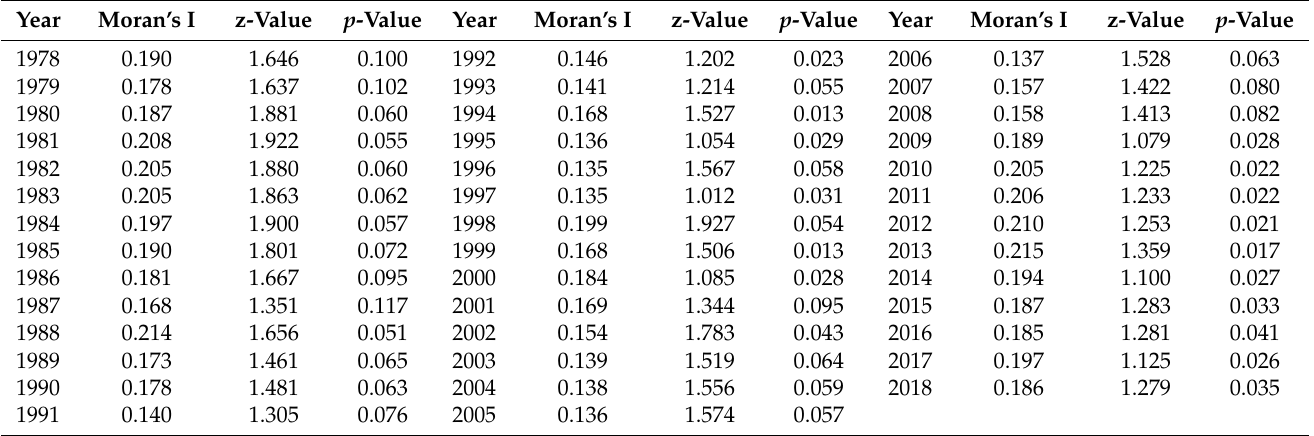
Table 3. The Moran’s I for APE since